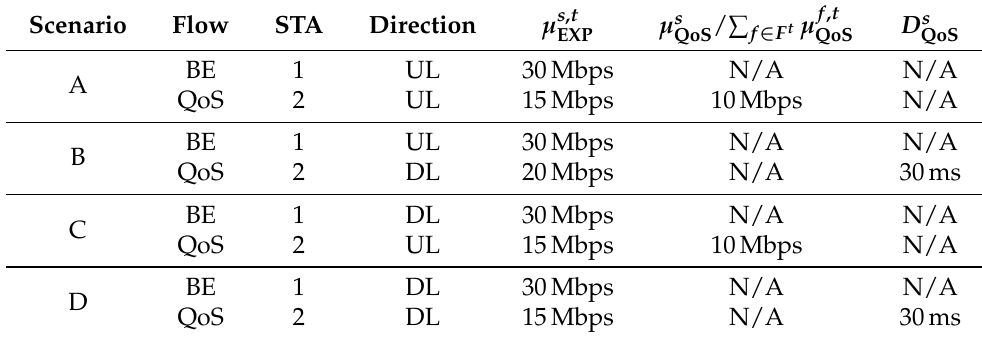
Table 5. Workload parameters used in experiment 1.